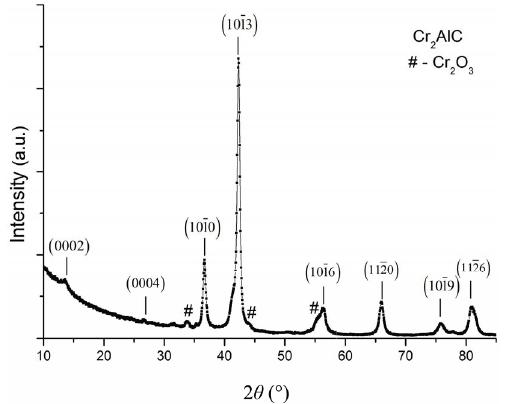
Fig. 6 Grazing-incidence XRD pattern of the sample 2a annealed at 700 ℃ for 30 min. Peak indexing, as resulted from the full-profile analysis is given on the